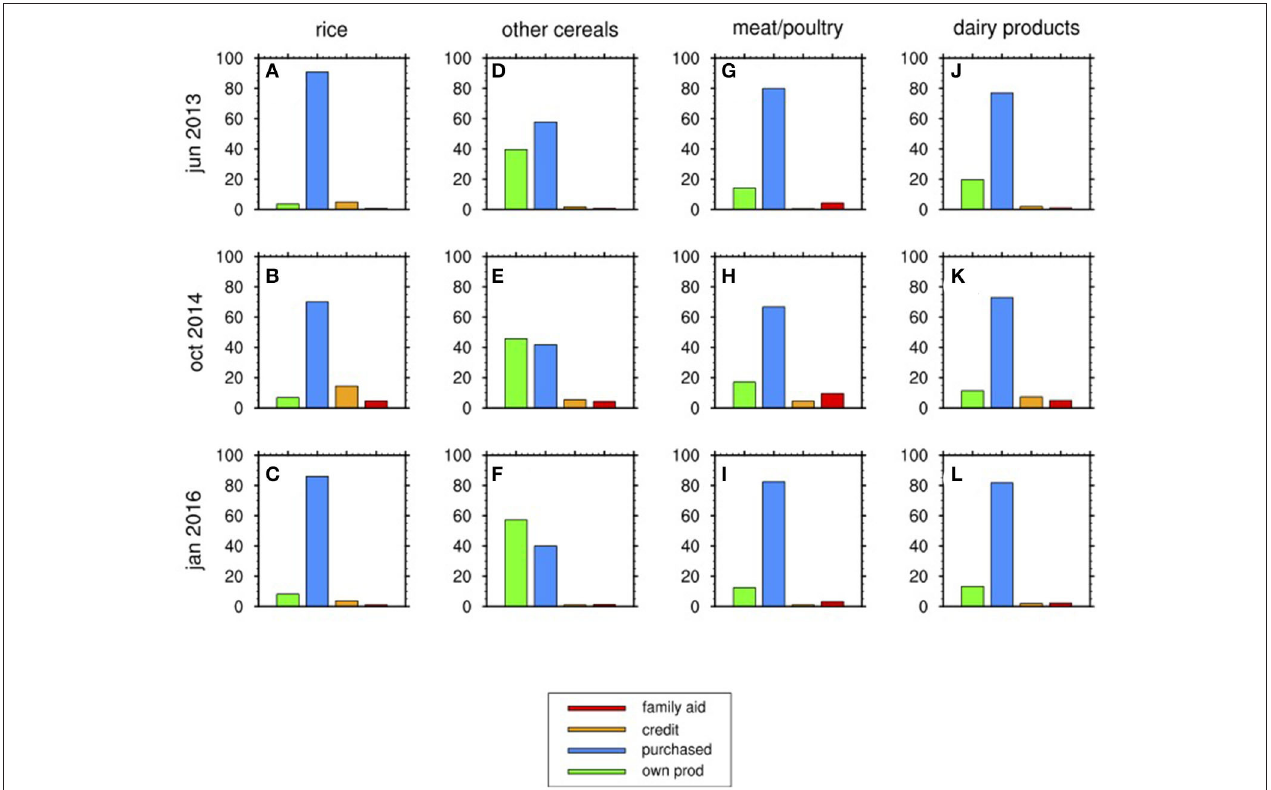
FIGURE 4 | The primary means by which food is accessed, for 4 main food items. Each row refers to a survey, 2013–2016 from top to bottom, and each column to the 4 food items considered, which are (A–C) rice, (D–F) other cereals (maize, millet, and sorghum), (G–I) animal protein (meat and poultry) and (J–L) dairy products, respectively. The 4 sources of food considered—own production in green, cash purchase in blue, credit purchase in orange, and aid from family and friends in red—are the most common